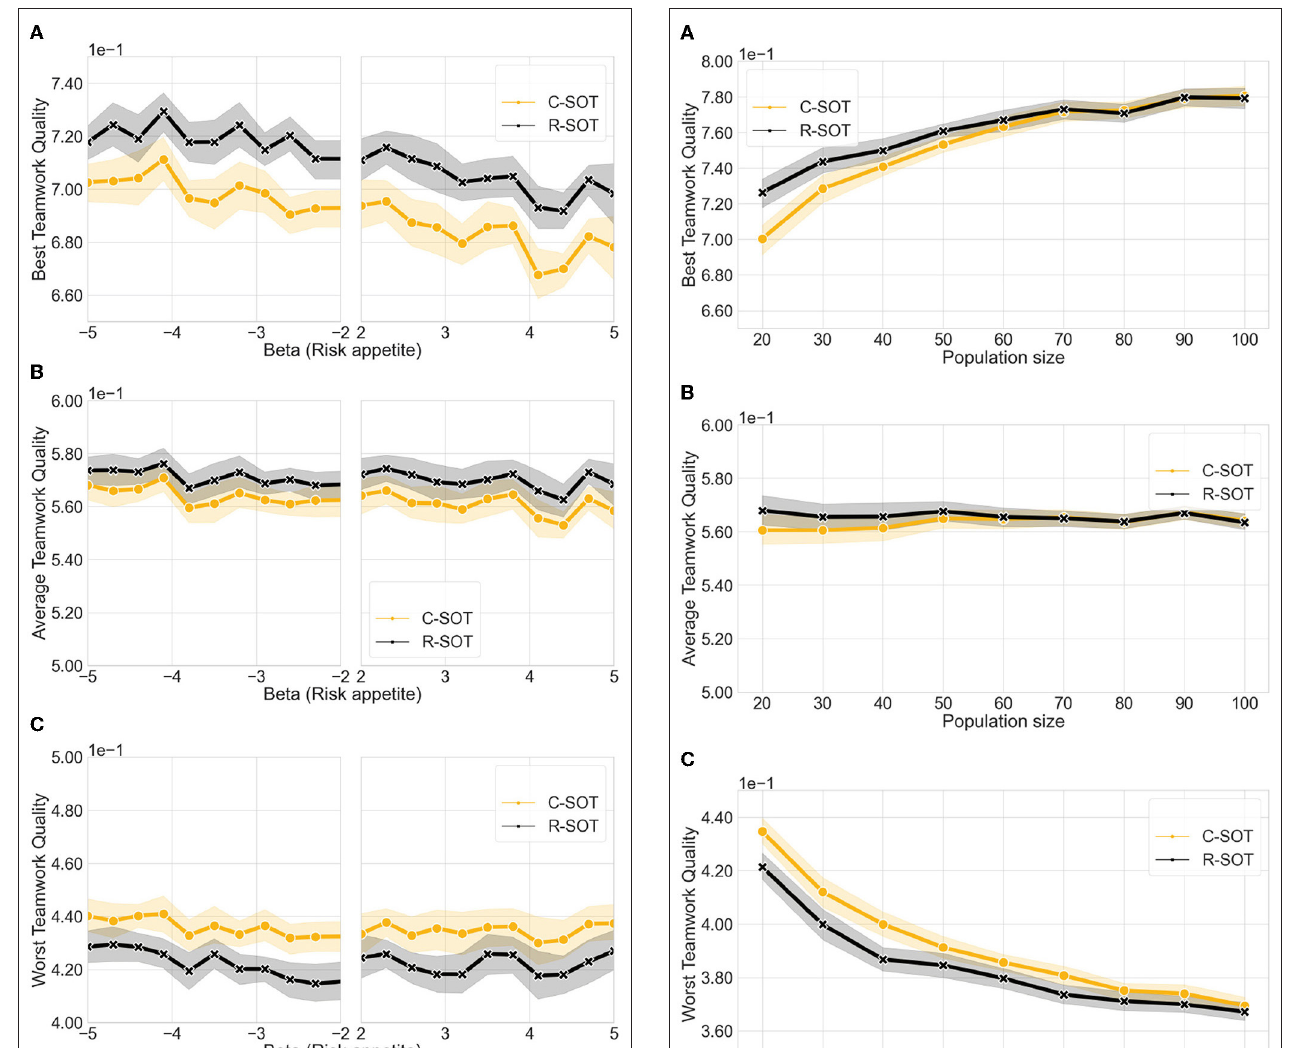
segregated quality outputs.